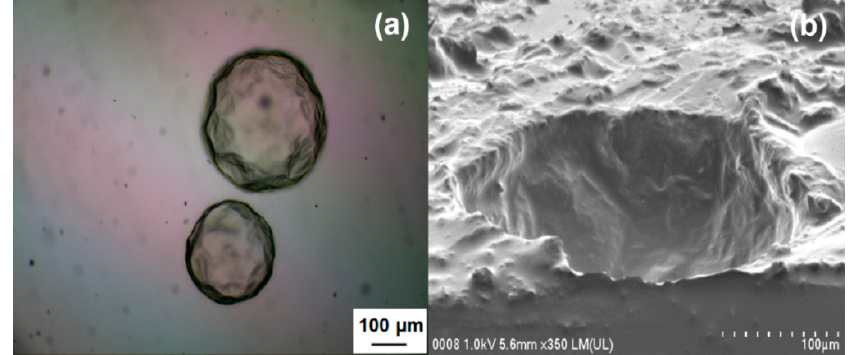
Figure 13. ( a ) Optical microscopic image of microcapsules embedded in the epoxy matrix; ( b ) FESEM